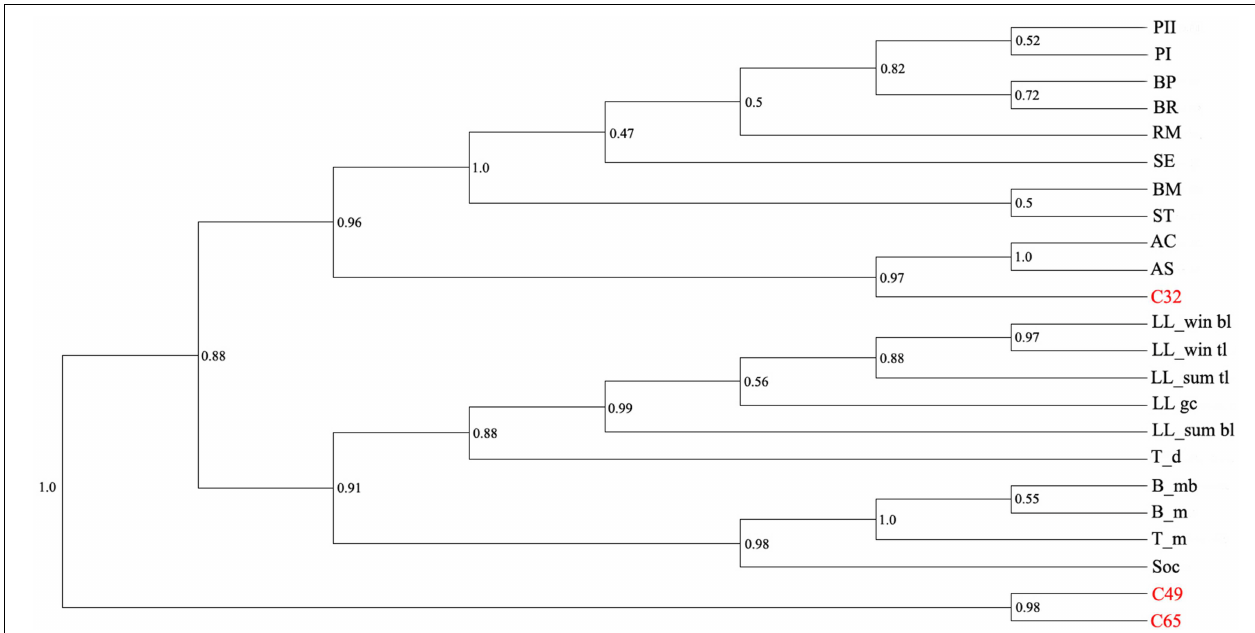
FIGURE 6 | Comparative analysis (UPGMA similarity tree) of microbial diversity in the Ciocaia samples with existing microbial mat/microbialite studies. A closed-reference OTU picking was performed via QIIME ( Caporaso et al., 2010a) at 97% sequence similarity, and the UPGMA tree constructed with unweighted-UniFrac (Lozupone and Knight, 2005). Sample codes: PI and PII, Pozas Azules I and II; BP, Pirate Channel; BR, Los Rapidos; RM, Rio Mesquites; SE, lagoon microbialite; BM, soft microbialite; ST, microbial mat; AC, columnar microbialite Alchichica lake; AS, spongy microbialite Alchichica lake (accession no.